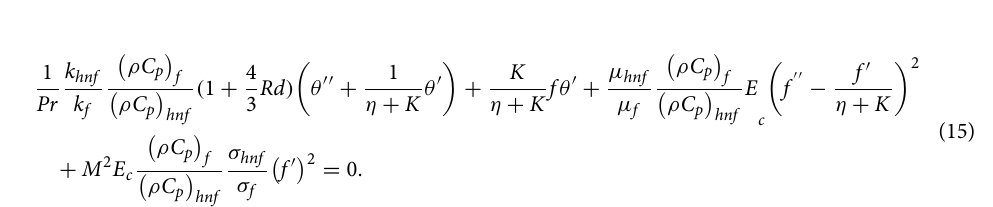
Table 2. Thermophysical properties of the base fluid ( C 2 H 6 O 2 ) and the nanoparticles ( Al 2 O 3 ) and Cu . 24,41 .